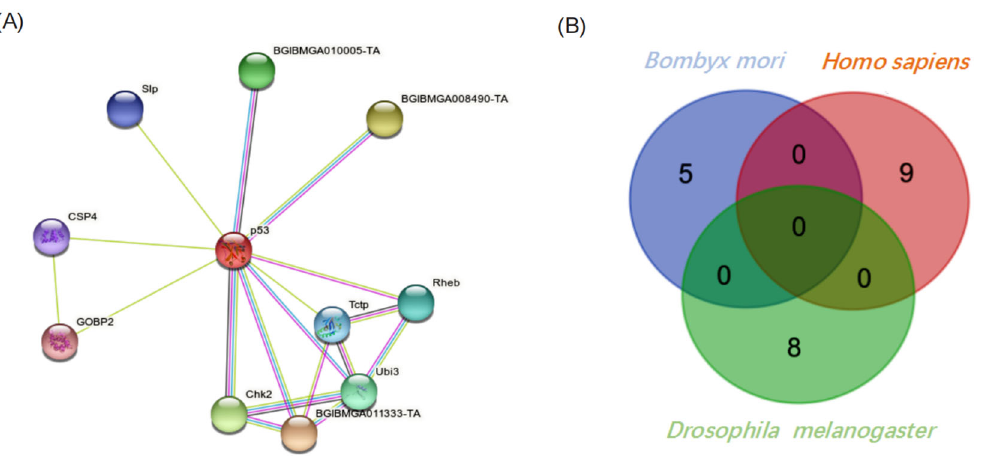
Figure 5. The Bmp53 apoptotic interactome. ( A ) Predicted network of protein interactions linked to Bmp53. ( B ) Venn diagram depicting the absence of overlap in p53 interacting proteins that comprise the apoptosis regulatory pathway in Homo sapiens and Drosophila melanogaster .